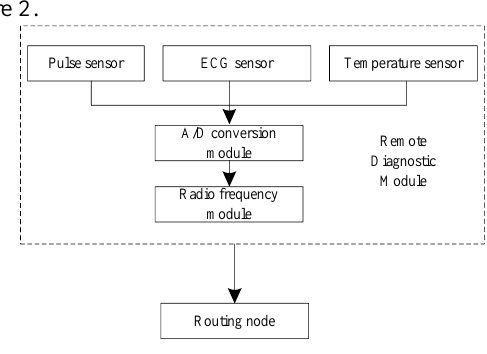
Figure 2. Wireless sensor network